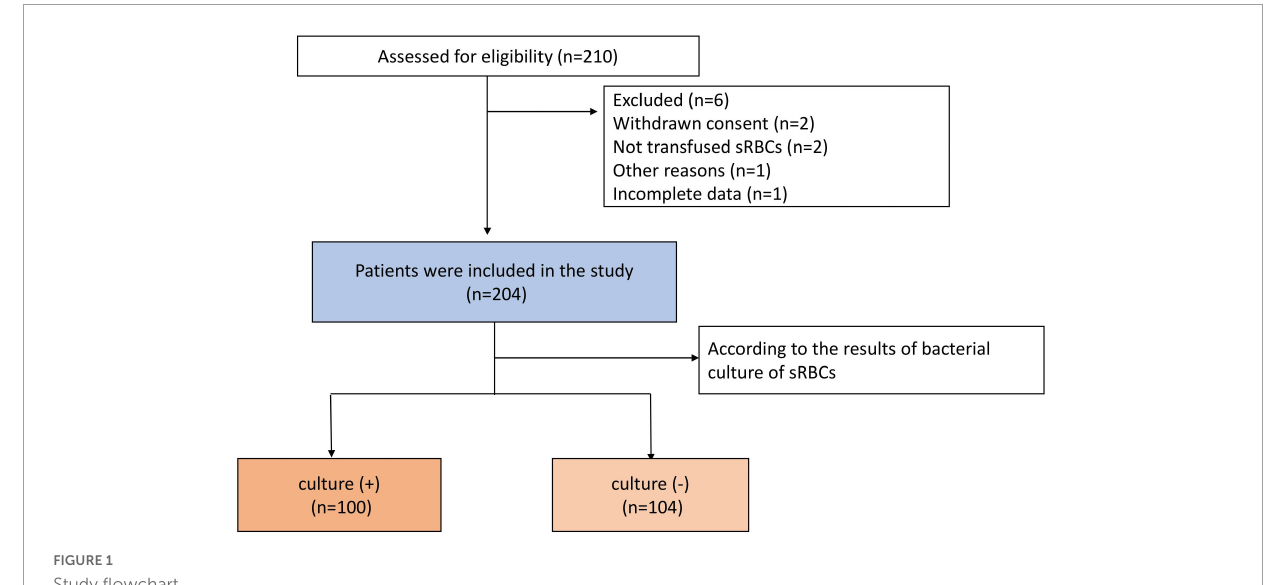
FIGURE1 Study flowchart.